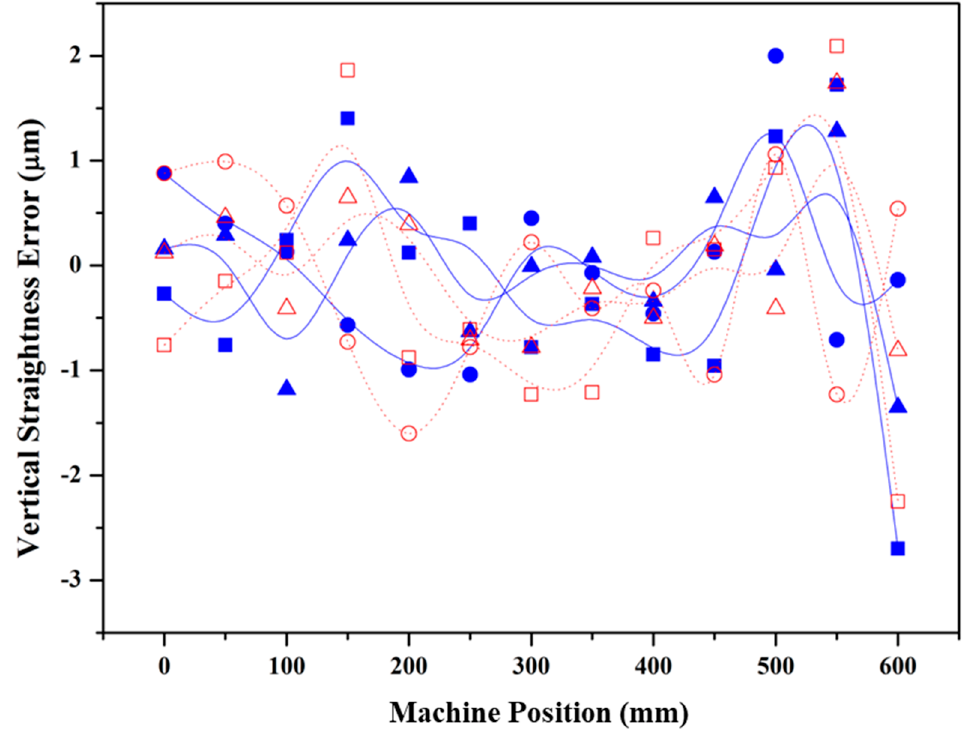
Figure 12. Vertical straightness errors of single-axis measurement verification: ■▲● —laser Figure 14. Vertical straightness errors of single-axis measurement verification: Figure 14. Vertical straightness errors of single-axis measurement verification: ■▲● —laser Figure 14. Vertical straightness errors of single-axis measurement verification: ■▲● —laser interferometer, and □ △〇 —proposed system. interferometer, and (cid:3) (cid:52) —proposed interferometer, and □ △〇 — proposed system. interferometer, and □ △〇 — proposed system. (cid:35)